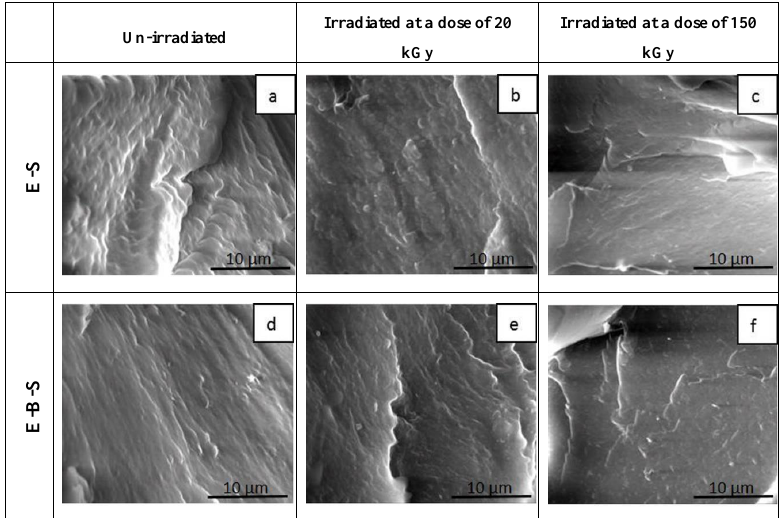
Figure 12. Micrographs of fractured surfaces of EPDM/rubber/nanosilica composites before and after irradiation (10,000 X magnification): ( a ) E-S 0 kGy, ( b ) E-S 20 kGy, ( c ) E-S 150 kGy, ( d ) E-B-S 0 kGy, ( e ) E-B-S 20 kGy, ( f ) E-B-S 150 kGy.